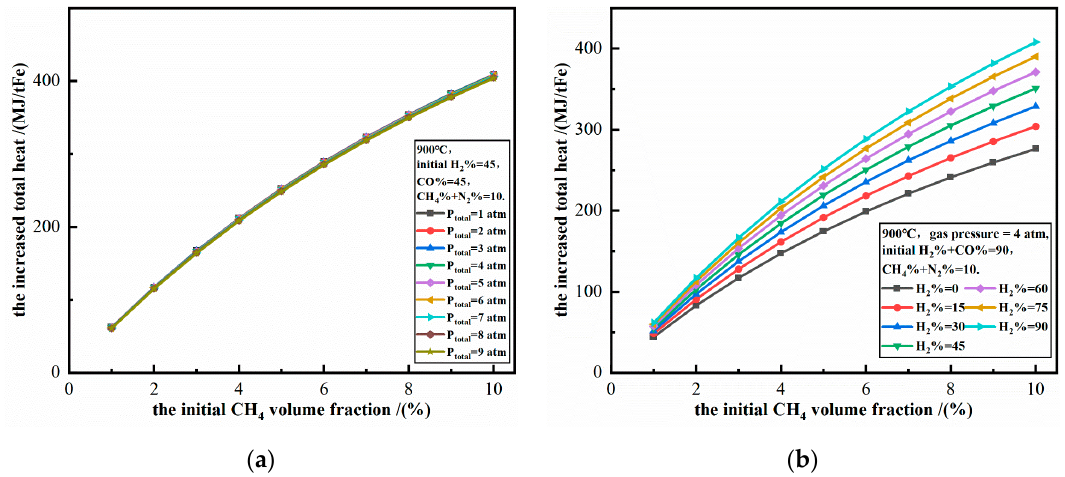
Figure 13. The relationship between the increased total heat and the initial CH 4 volume fraction at 900 °C. ( a ) H 2 % = 45, CO% = 45, total pressure is 1–9 atm; ( b ) H 2 % + CO% = 90, total pressure is 4 atm.